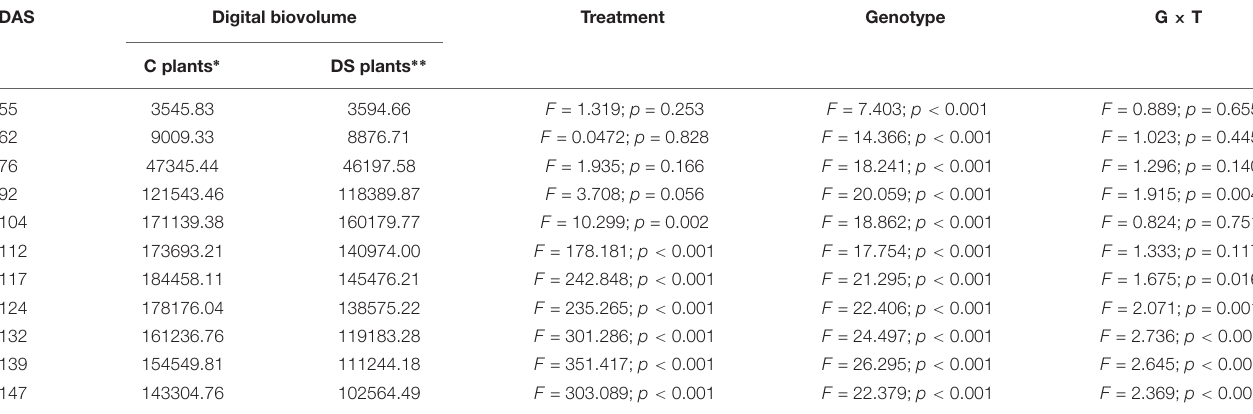
F statistic represents the ratio between estimated population variance between groups and estimated population variance within groups. ∗ C plants: control plants; ∗∗ DS plants Drought Stressed plants.